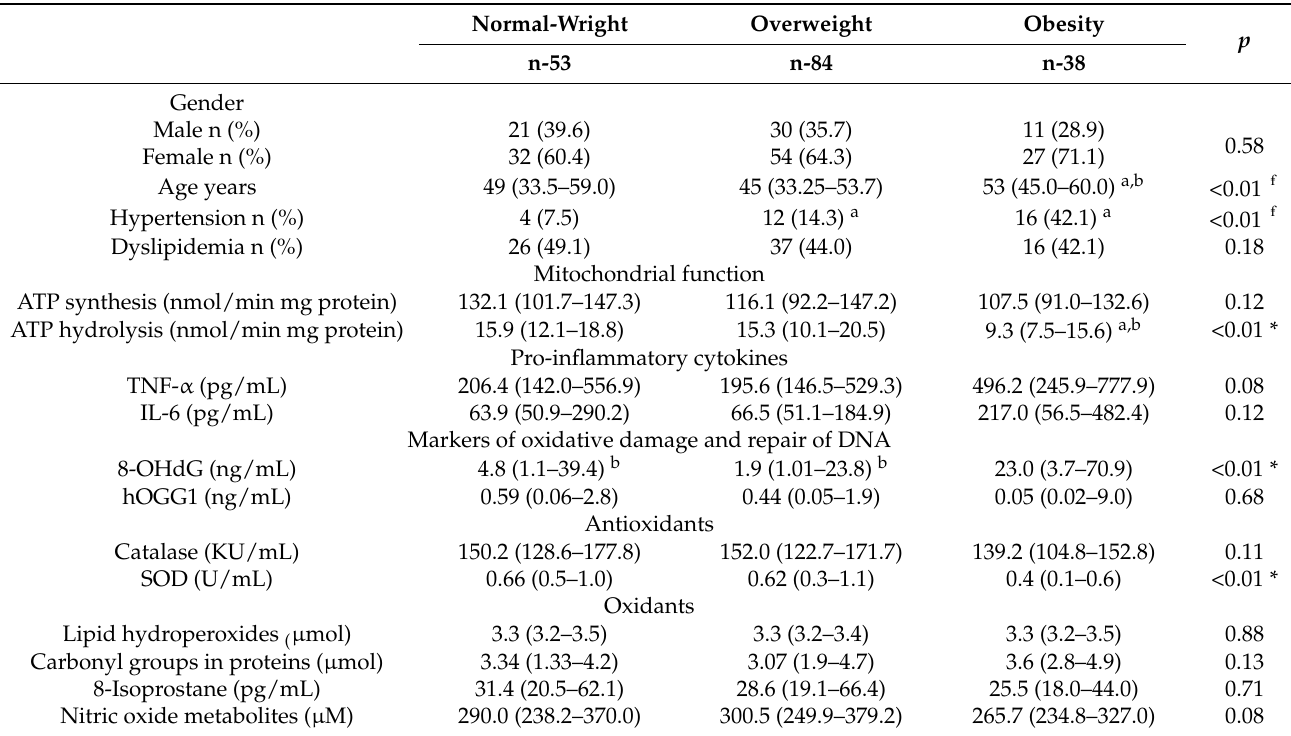
Table 1. Demographic data, ATP synthesis rate, ATP hydrolysis rate, oxidative stress, and proinflammatory markers in subjects with normal weight, overweight, and obesity.